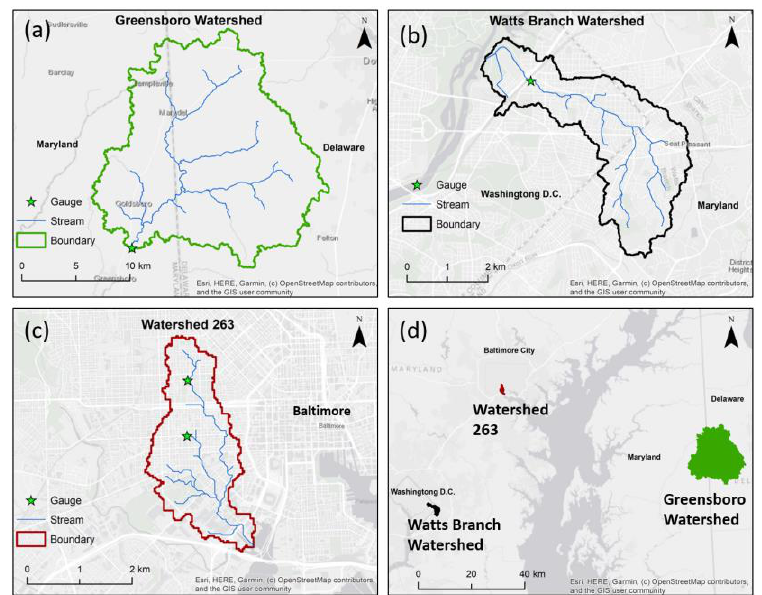
Figure 1. Location of the three study watersheds: ( a ) agricultural Greensboro watershed between Maryland and Delaware; ( b ) suburban Watts Branch watershed between Washington, D.C., and Maryland; ( c ) ultra-urban Watershed 263 in Baltimore city; and ( d ) relative position of three watersheds.